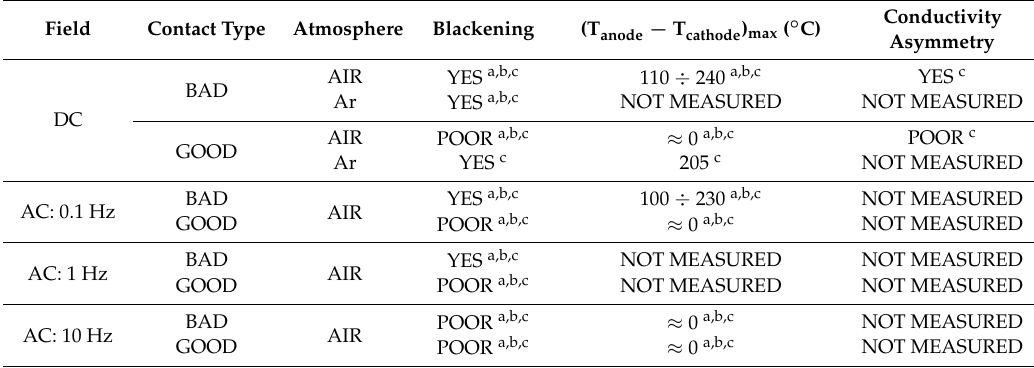
Table 1. Summary of key results obtained in terms of blackening, temperature and conductivity asymmetry. The sample type is identified by a superscript: a = 100 single crystal; b = 111 single